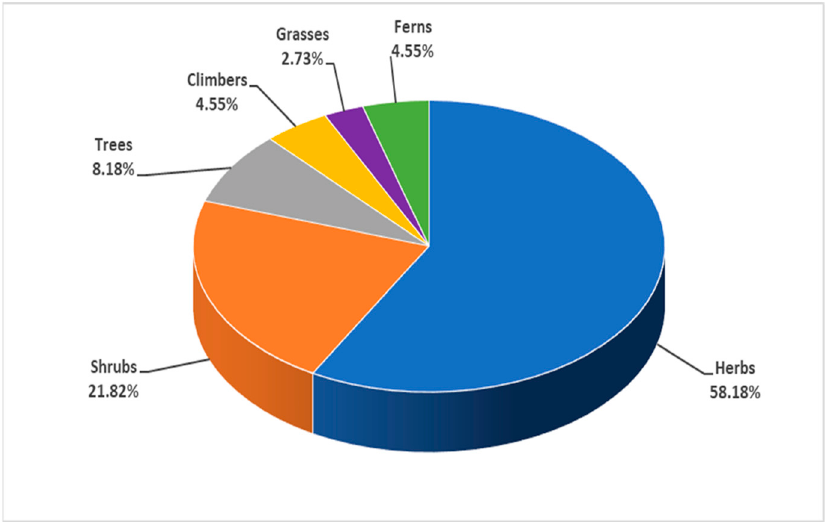
Figure 3. Percentage of growth forms of plant species at study site.